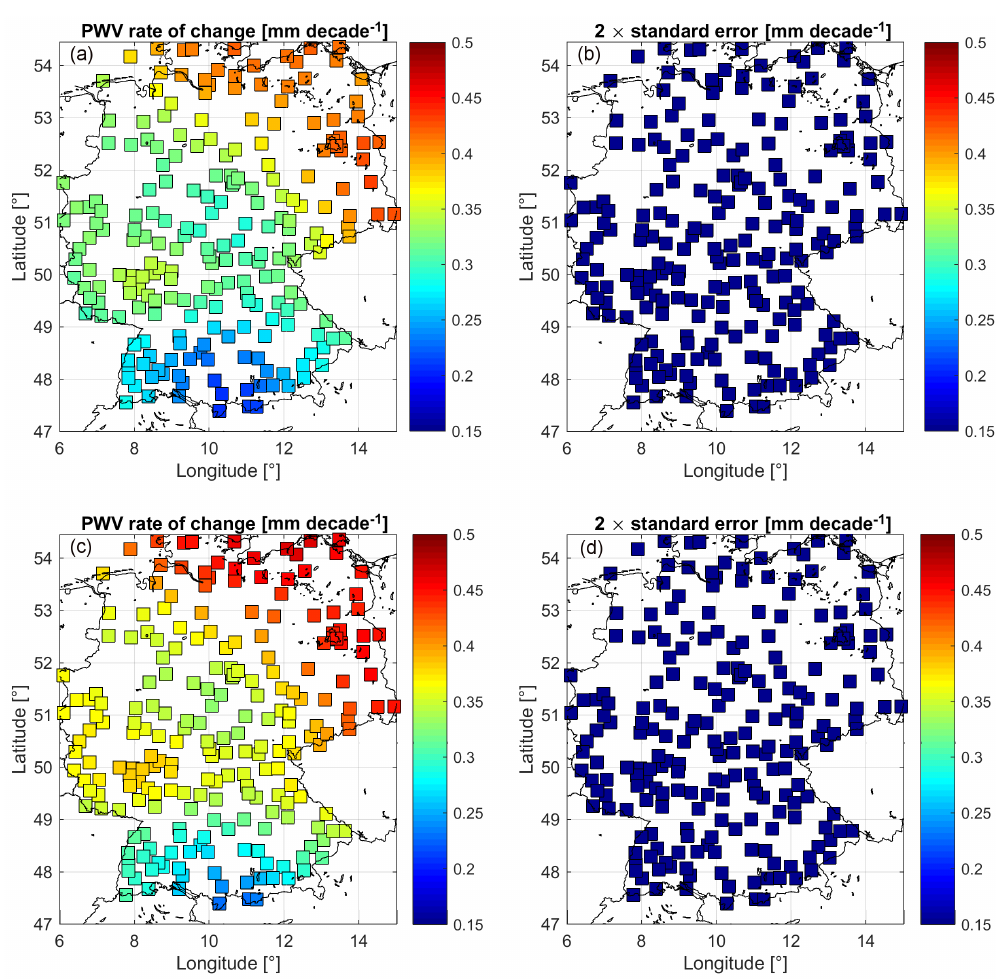
Figure 9. The estimated PWV trend using (2m) ERA-Interim data by applying least squares regression to the seasonally adjusted time series (a) and Theil–Sen estimator (c) . The standard errors of the estimated trends are shown in panels (b, d)